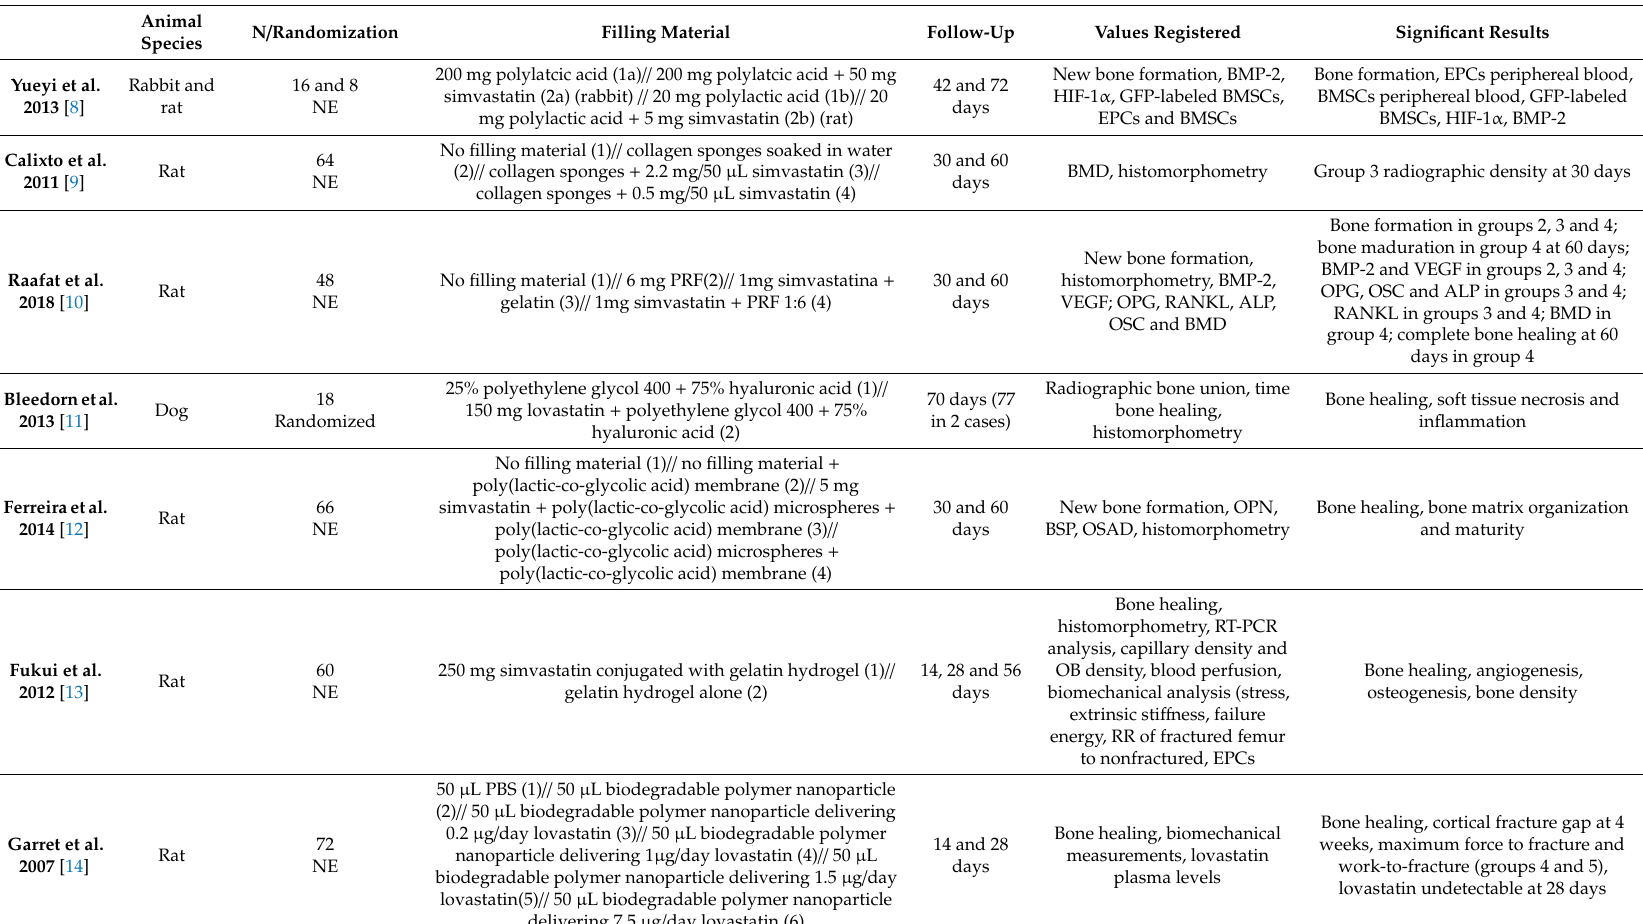
Table 1. Summary of the animal studies